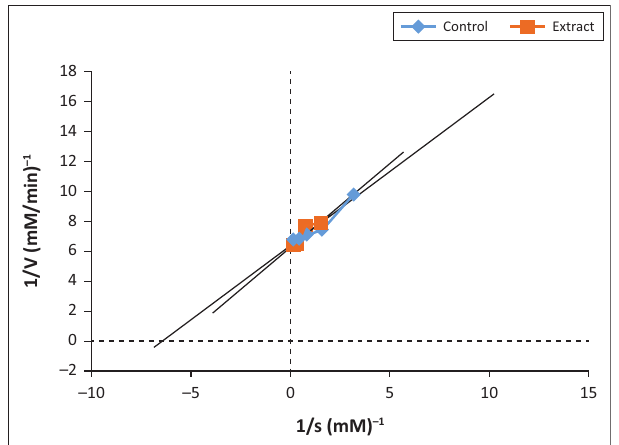
FIGURE 1: Mode of inhibition of α-amylase by aqueous root extract of E. elephantina showing a near-competitive inhibition.